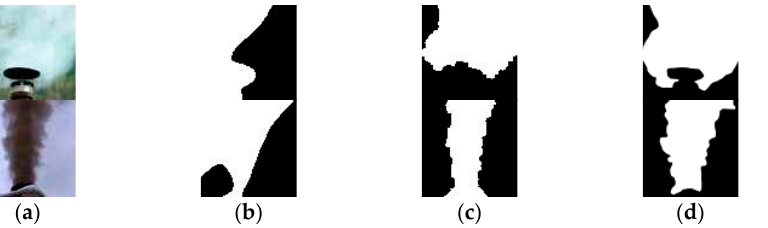
Figure 7. Segmentation results with and without superpixel module. ( a ) Smoke image; ( b ) no super -pixel module; ( c ) with superpixel module; ( d ) manually labeled image.